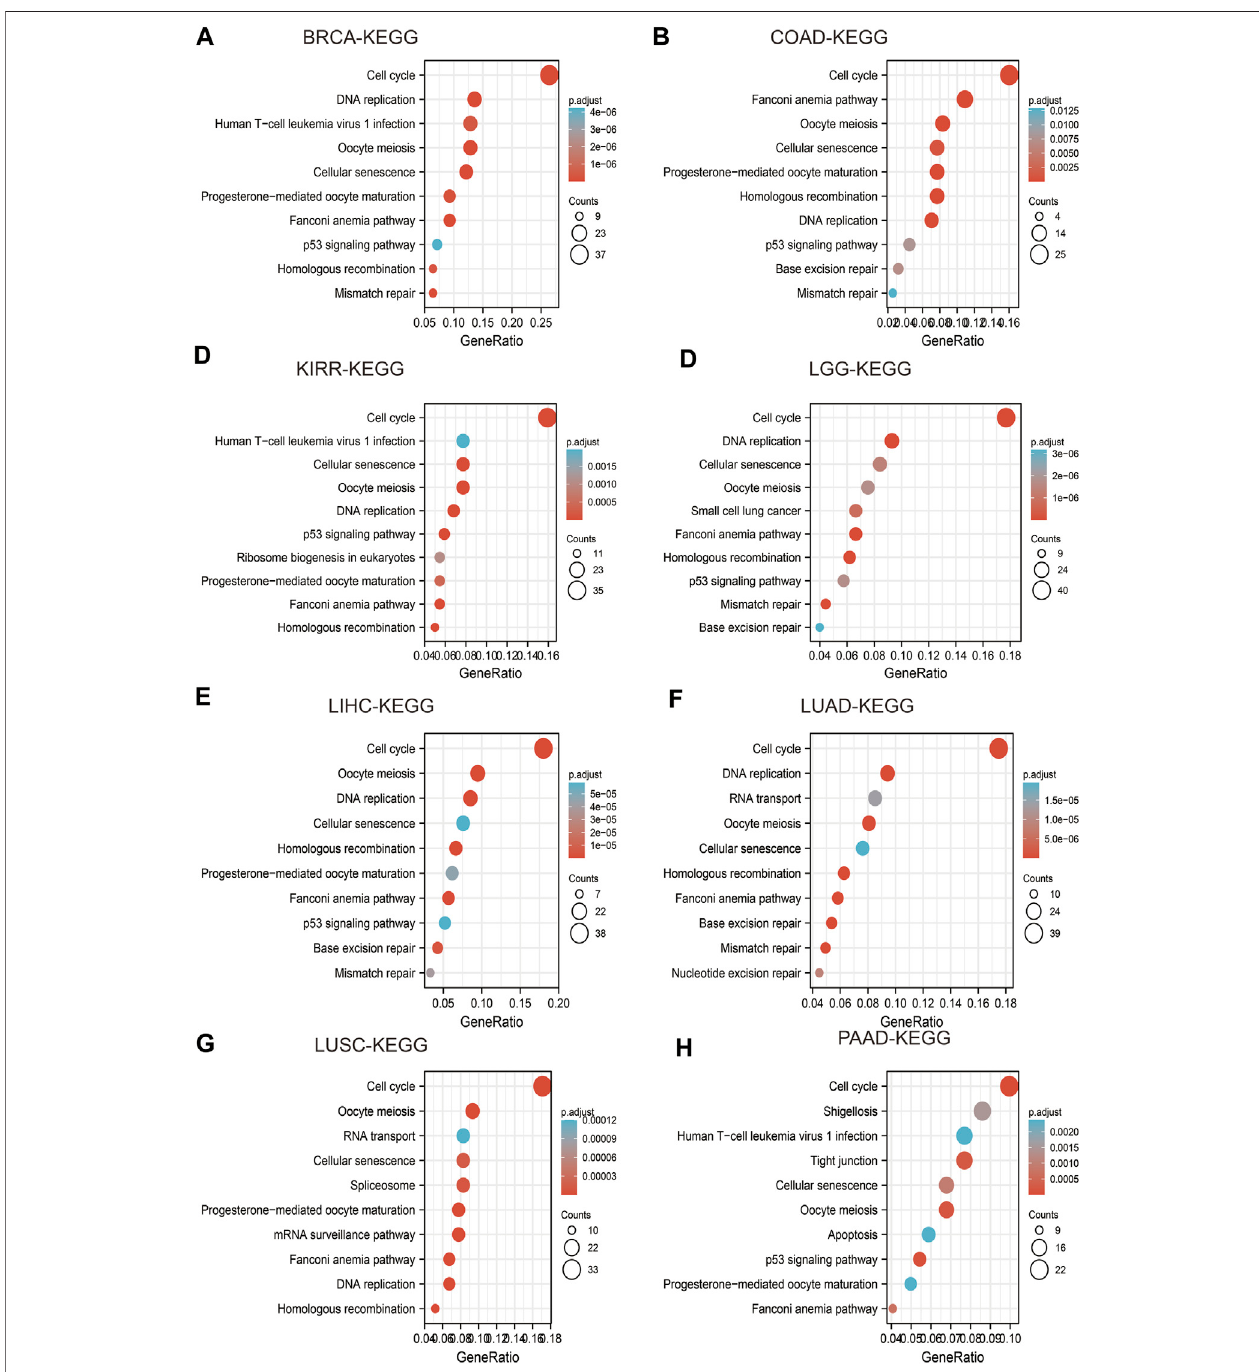
FIGURE9| AnalysisofthesignalingpathwayforIQGAP3inhumancancers. (A – D) TheKEGGpathwayofIQGAP3inBRCA,COAD,KIRP,andLGGwasanalyzed by using LinkedOmics. (E – H) The KEGG pathway of IQGAP3 in LIHC, LUAD, LUSC, and PAAD analysis by LinkedOmics.